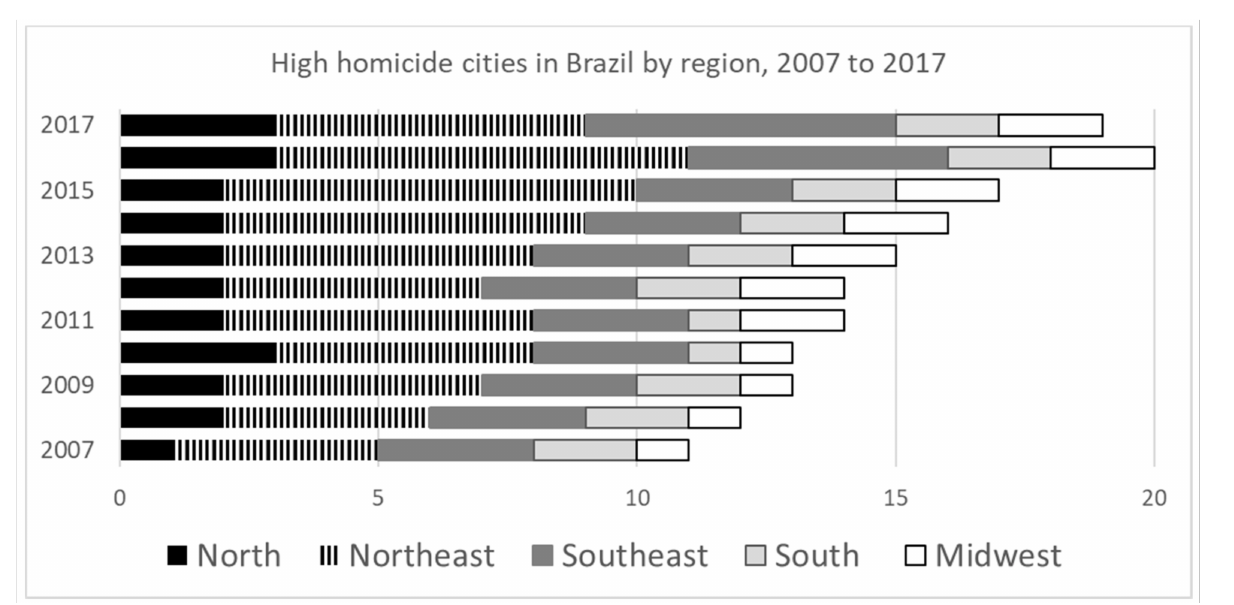
Figure 1. HHCs in Brazil, by region.